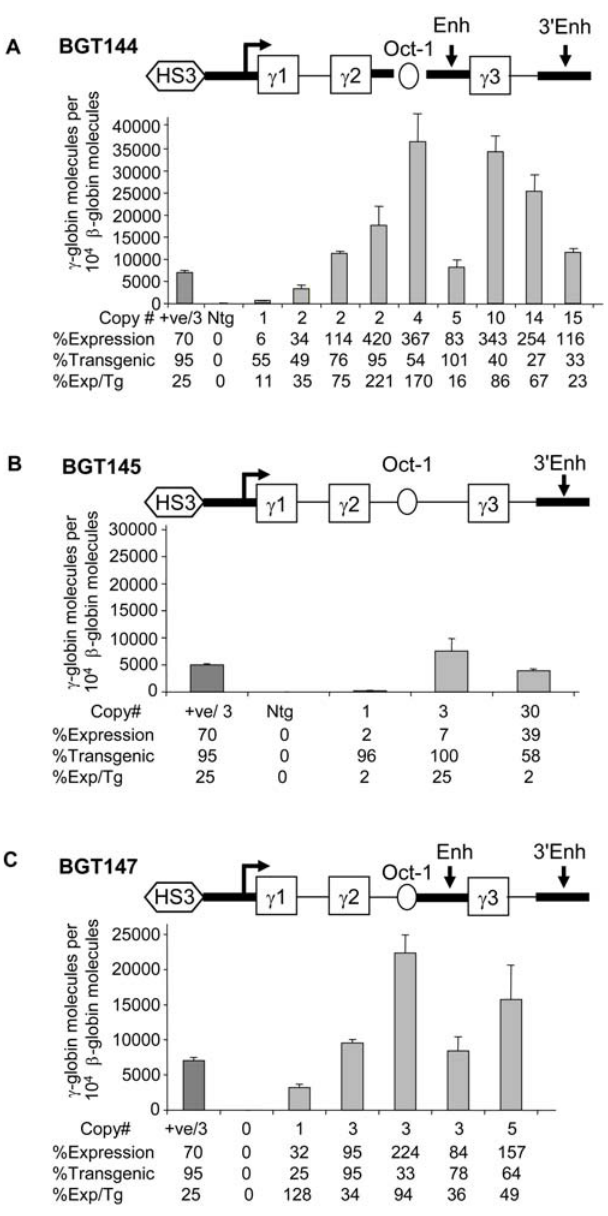
Figure 2. The Oct-1 site increases LCR b / c -globin transgene expression by cooperating with the intronic enhancer. (A) RNA expression analysis using qRT-PCR on fetal liver tissue from BGT144 transgenic animals. The mean expression per transgene from qRT-PCR performed in triplicate for BGT144 is 78% 6 24 (standard error-SE). (B) qRT-PCR results from BGT145 transgenic animals show that mean expression per transgene is 10% 6 8. C) qRT-PCR results from BGT147 transgenic animals show that mean expression per transgene 68% 6 18. In each case, the amount of product from amplification reactions with a primer set specific for the human b / c -globin transcript was scaled relative to 10 4 molecules from amplification reaction with primers specific for the mouse b major-globin gene. The positive control ( + ve) is a previously published BGT64 sample (FF334) and the negative control (Ntg) is a nontransgenic